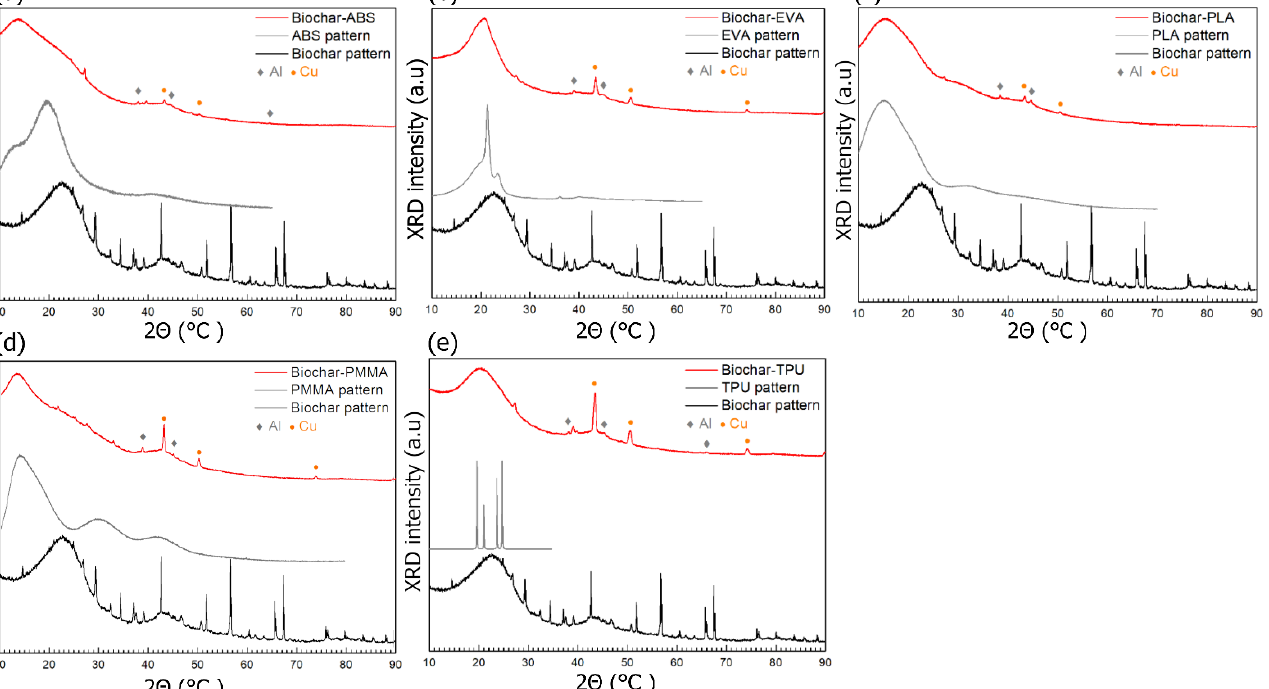
Figure 4. XRD results of ( a ) ABS-biochar, ( b ) EVA-biochar, ( c ) PLA-biochar, ( d ) PMMA-biochar (50 wt.% biochar), and ( e ) TPU-biochar (60 wt.% biochar). Experimental diffractograms are marked with the red line. The grey line depicts the polymer pattern taken from the ICDD database, while the black line being an experimental pattern of biochar. The diffractograms of composites (red lines) presented in Figure 4 show the contin- uous and broad-peak shape change of signals. This indicates a lack of crystallinity of com- posites. For comparison, the experimental pattern of pure biochar (black lines) and poly- mer patterns (grey lines) are presented. Polymer patterns were taken from the ICDD PDF-